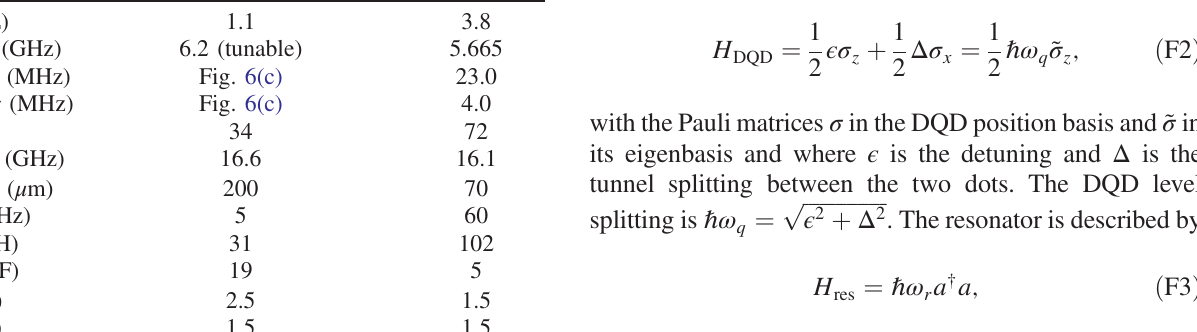
TABLE V. Comparison between SQUID and JJ array resonators. SQUID array Junction